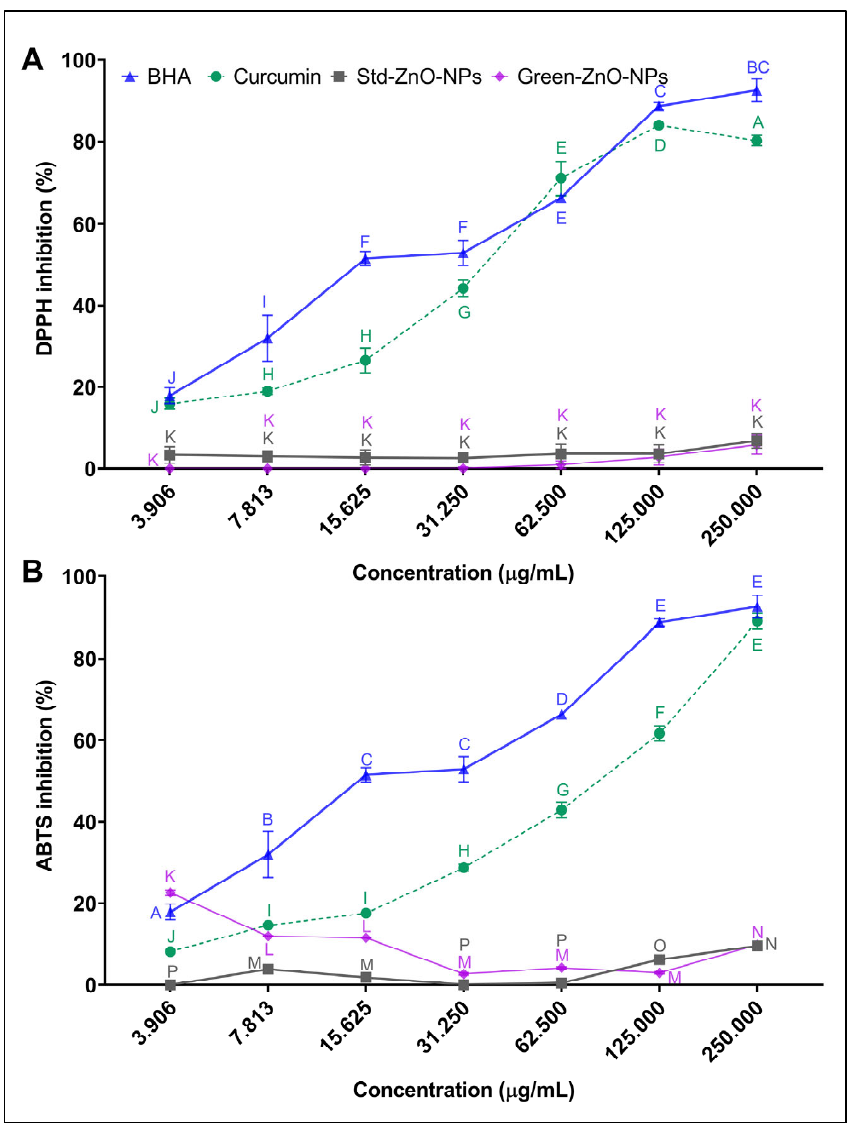
Figure 7. ( A ) DPPH and ( B ) ABTS antiradical activity of Green-ZnO-NPs, Std-ZnO-NPs and curcumin. Tukey post hoc multiple comparison tests show a significant difference ( p < 0.05) between samples with different letters (mean ± SD; n = 3).